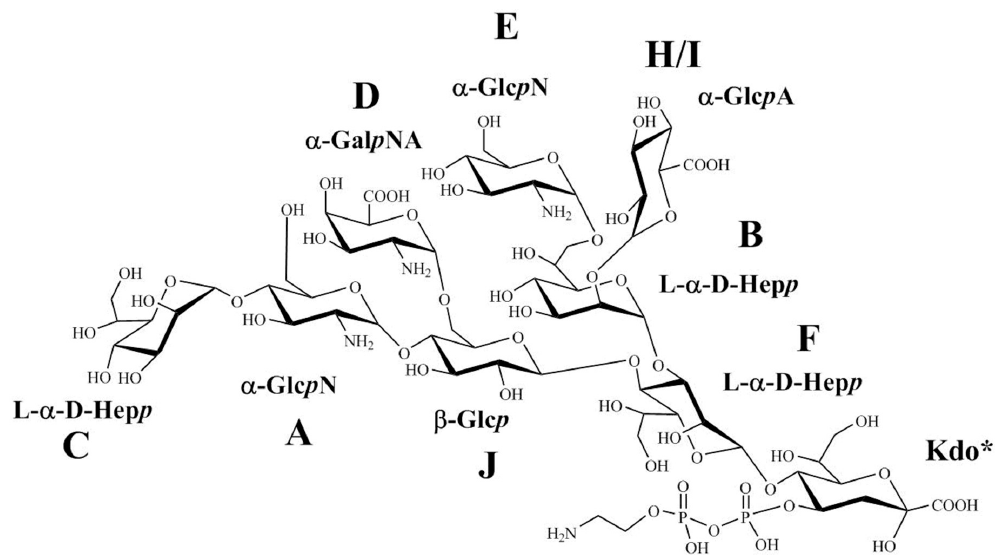
Figure 10. Structure of OS B. holmesii ATCC 51541, * Kdo was detected in the OS VIII fraction in the form of 4,7-anhydro-3-deoxy- D -manno-2-octulofuranosonic acid. The presence of ethanolamine is form of 4,7-anhydro-3-deoxy- d -manno-2-octulofuranosonic acid. The presence of ethanolamine is tentative (for indication see the supplementary data). tentative (for indication see the supplementary